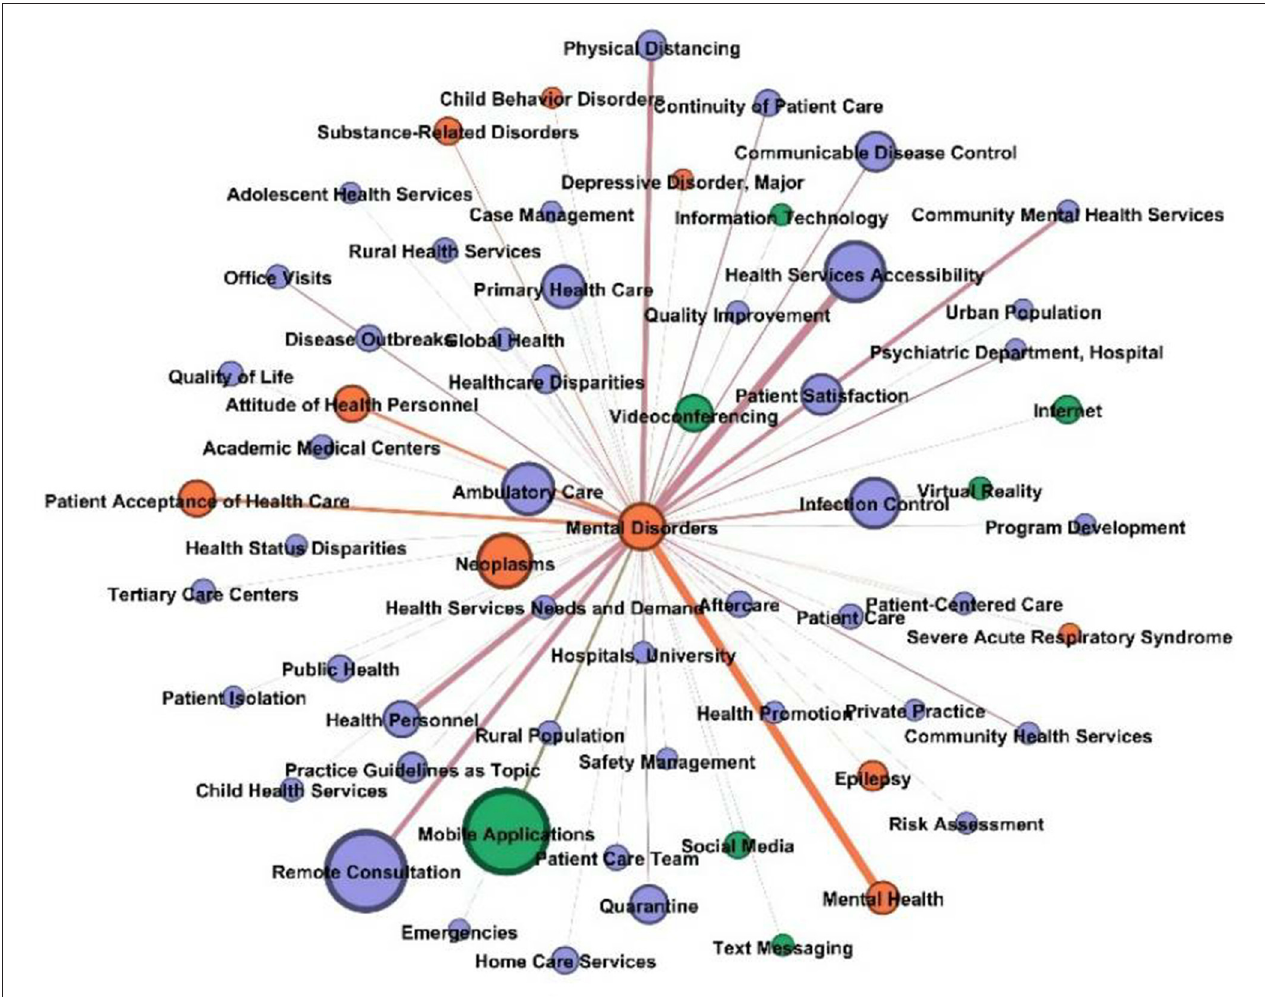
FIGURE 7 | Mental disorders node and other nodes connections in the network.